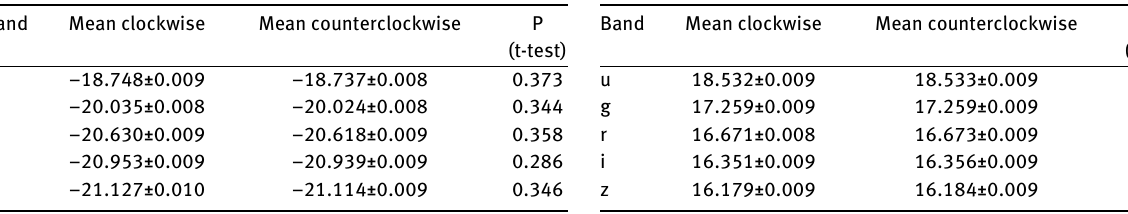
Table 9. The absolute magnitude of the subset of SDSS galaxies with spectra.